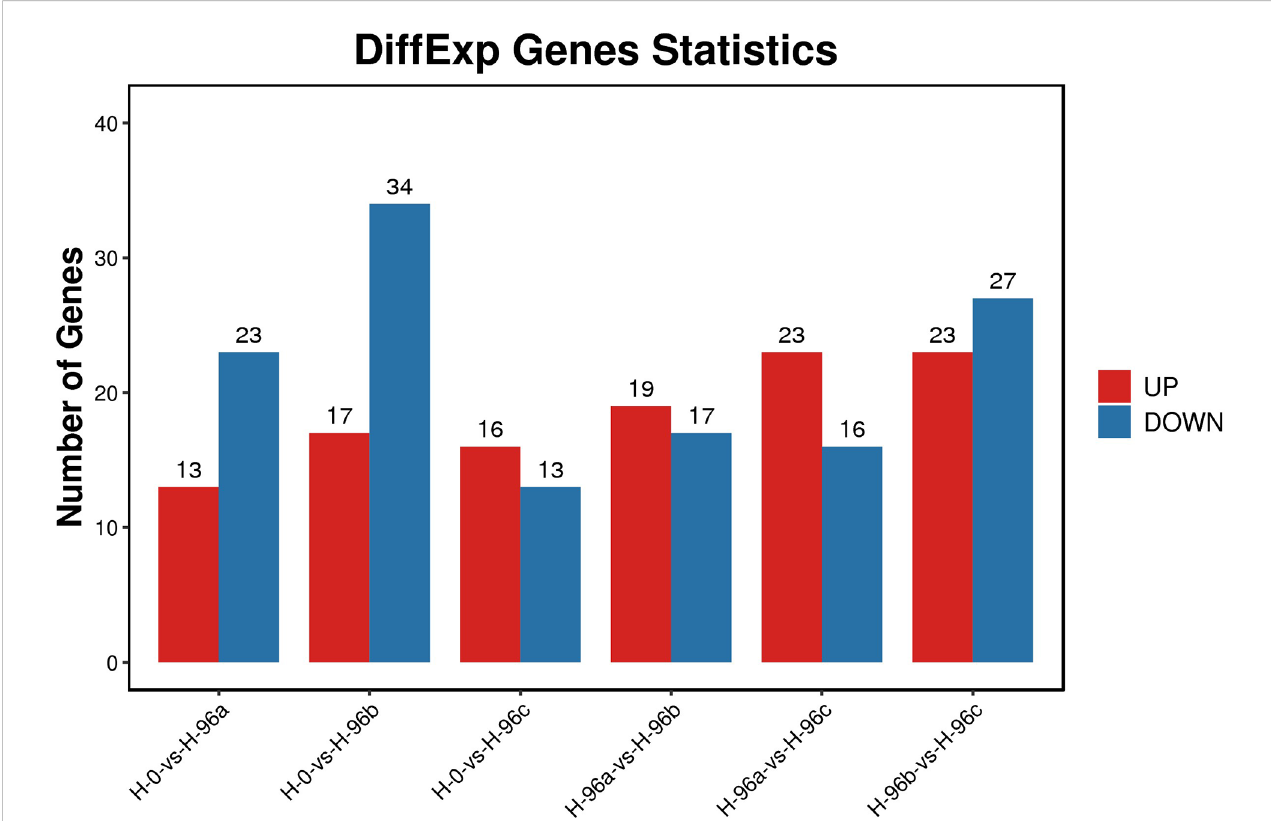
FIGURE 4 Statistical chart of DEGs. H-0: Control group; H-96a: concentration of 20 mg/L group; H-96b: concentration of 50 mg/L group; H-96c: concentration of 100 mg/L group. Up- and down-regulated genes are shown in red and blue,